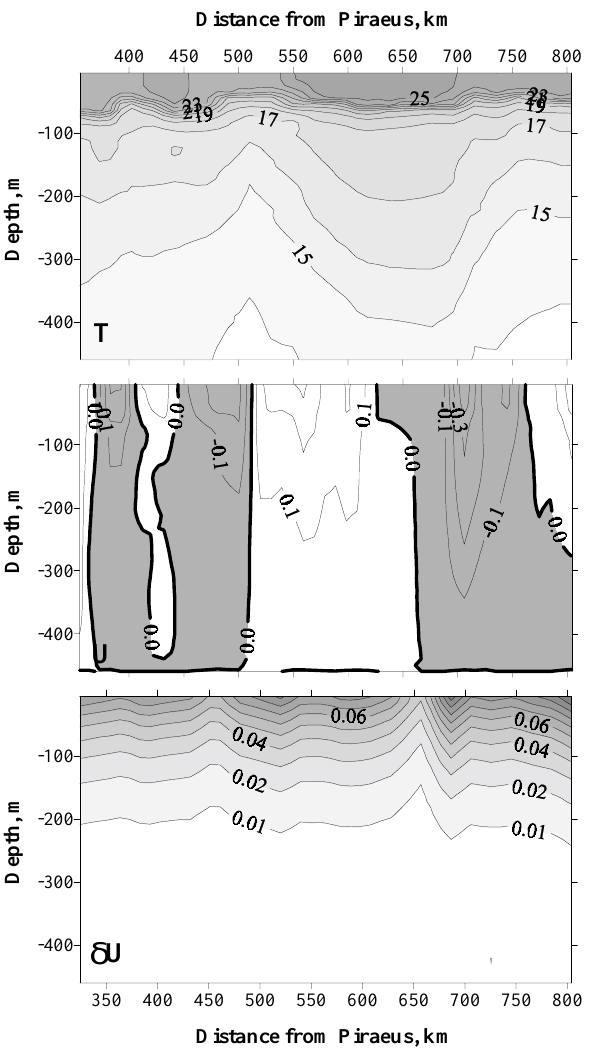
Fig. 7b. As in Fig. 7a, for the 4th crossing on 19 December